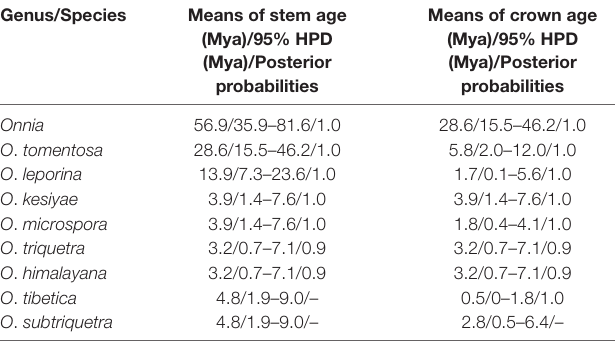
TABLE 2 | Inferred divergence time of species in the genus Onnia . Genus/Species Means of stem age (Mya)/95% HPD